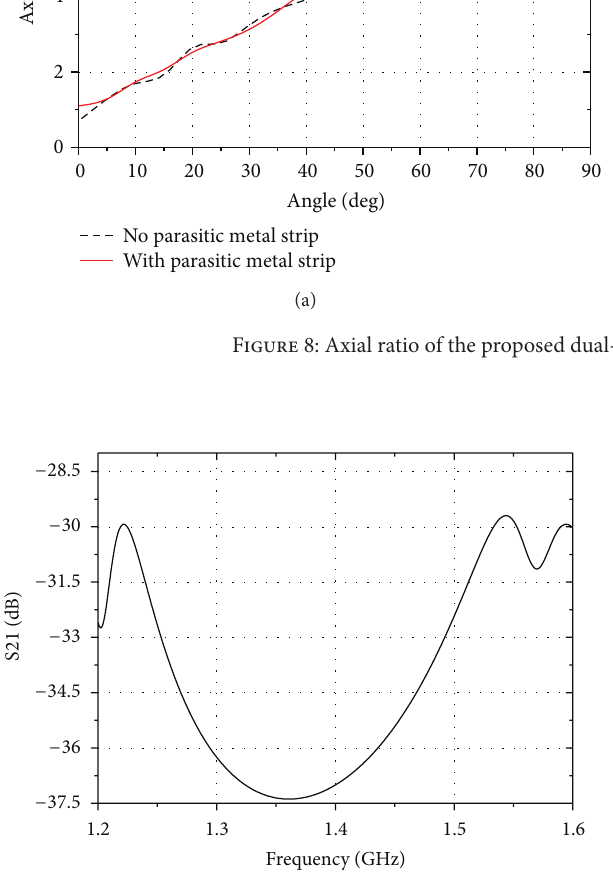
Figure 9: S21 versus the frequency for the two antennas.